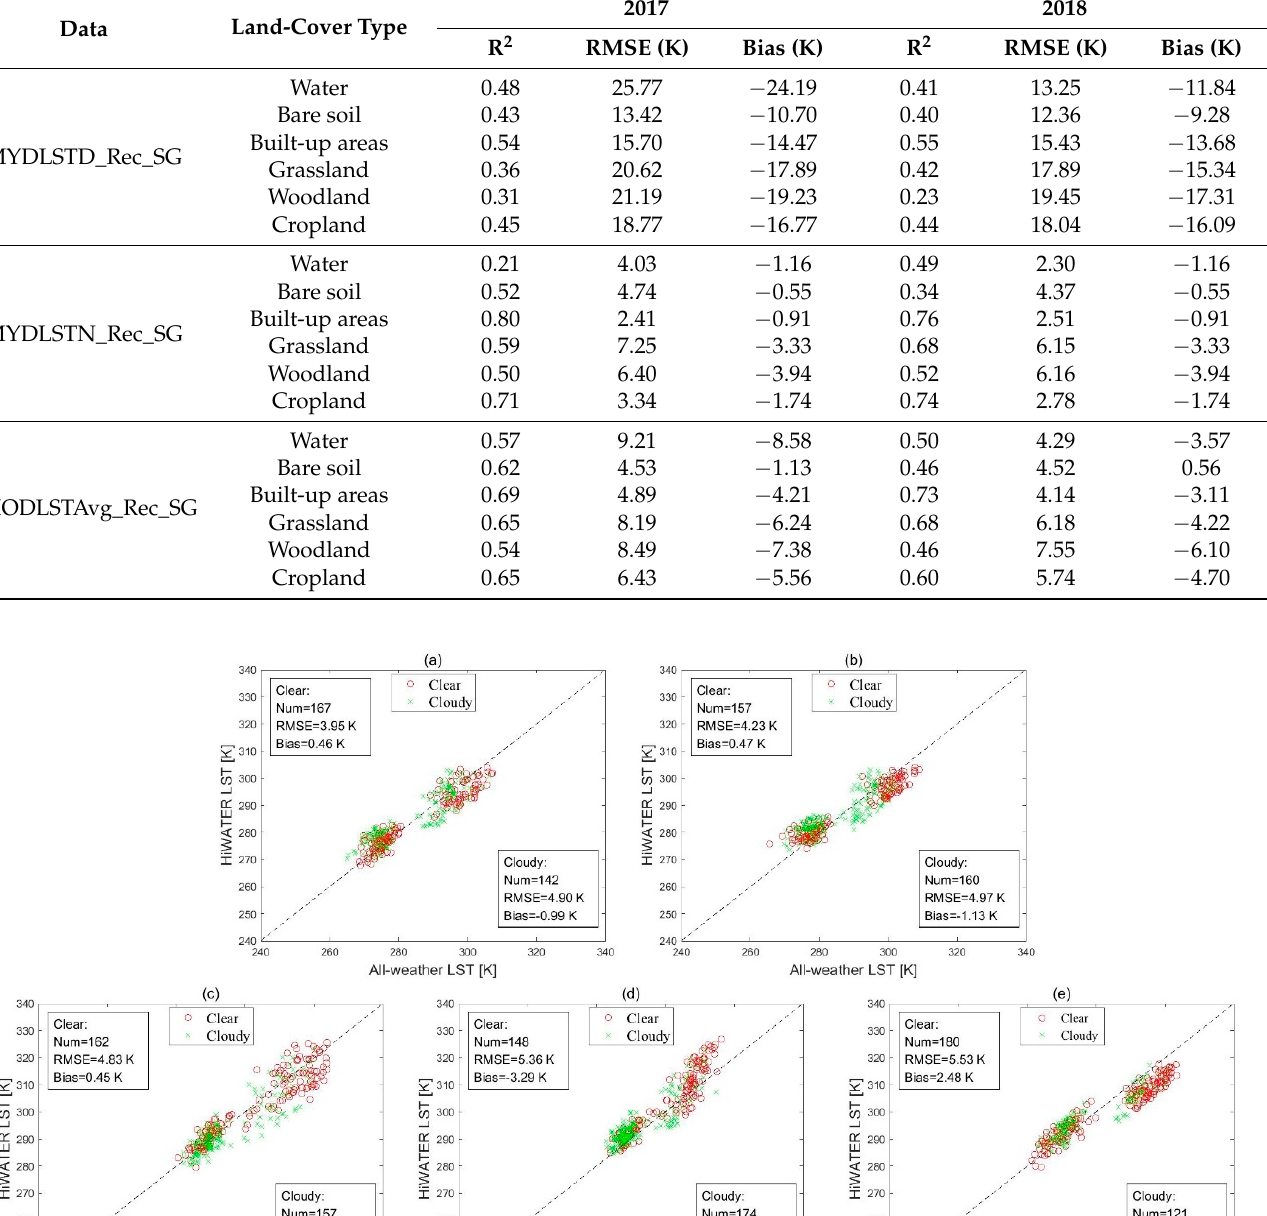
Table 4. Validation results of the reconstructed daytime and nighttime MYD11A1 LSTs, and average daily LST data from June to August in 2017 and 2018 for different land-cover types.